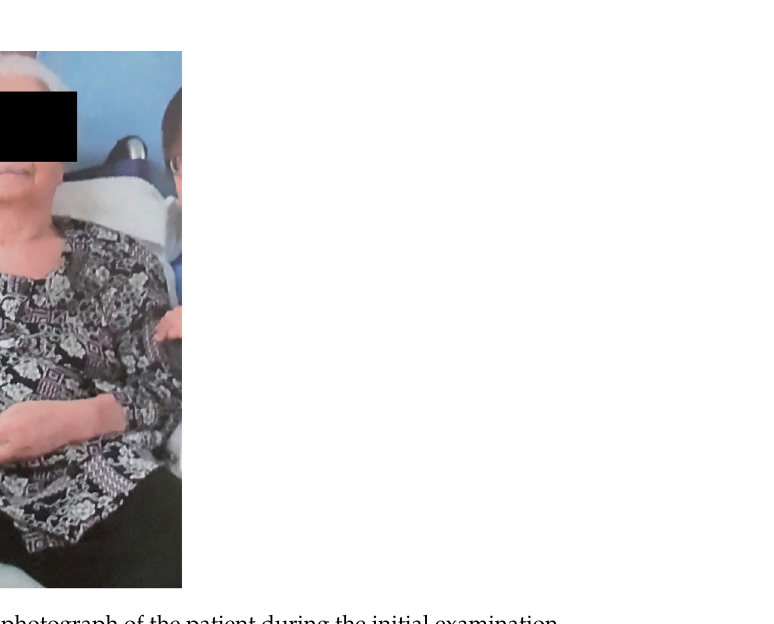
Figure 1. Frontal photograph of the patient during the initial examination. Table 1. Blood test results at the initial examination.